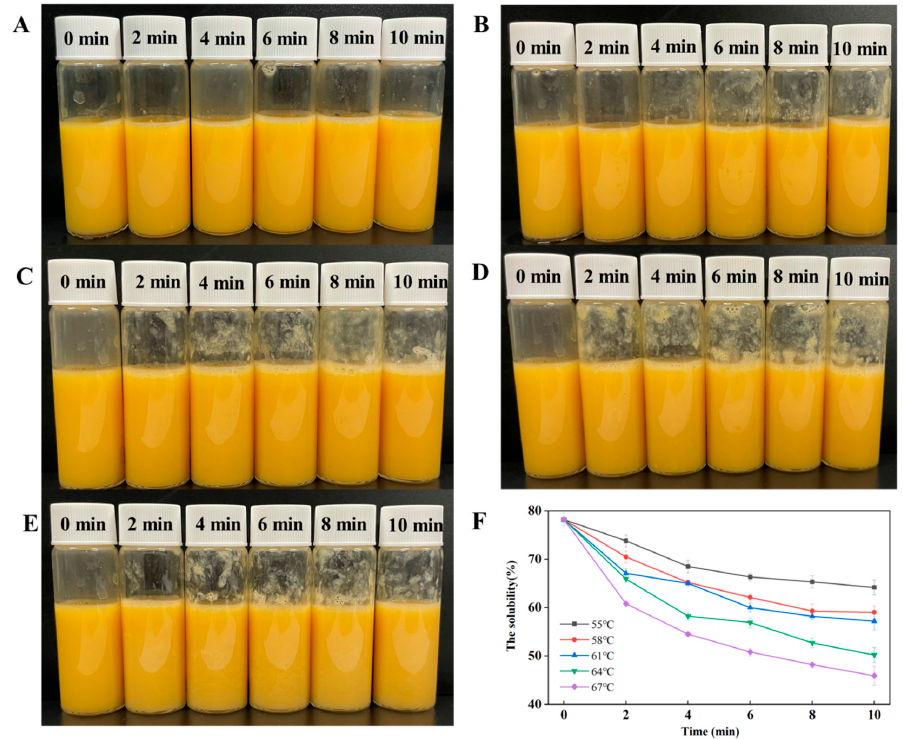
Figure 1. Effect of different heating treatment conditions on the appearance and solubility of